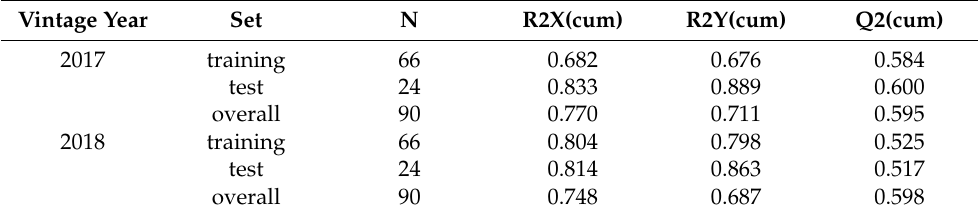
Table 7. The R2X(cum), R2Y(cum), and Q2(cum) scores of classifications for the wine samples between 2017 to 2018 regarding variety by